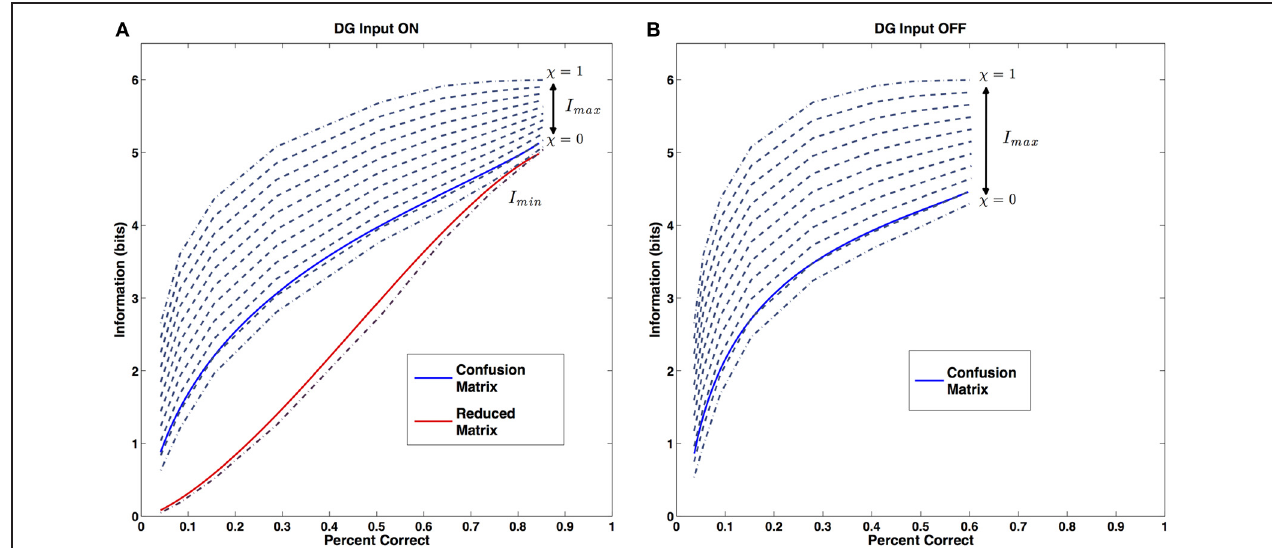
FIGURE 5 | Metric Resolution. (A) Metric resolution of the CA3 representation generated with the external DG input. Blue solid line: information content of the confusion matrix (close to χ ∼ 0 . 1). Red solid line: information content of the reduced matrix. Dark red dashed line: theoretical minimum for the information. Dark blue dashed lines: